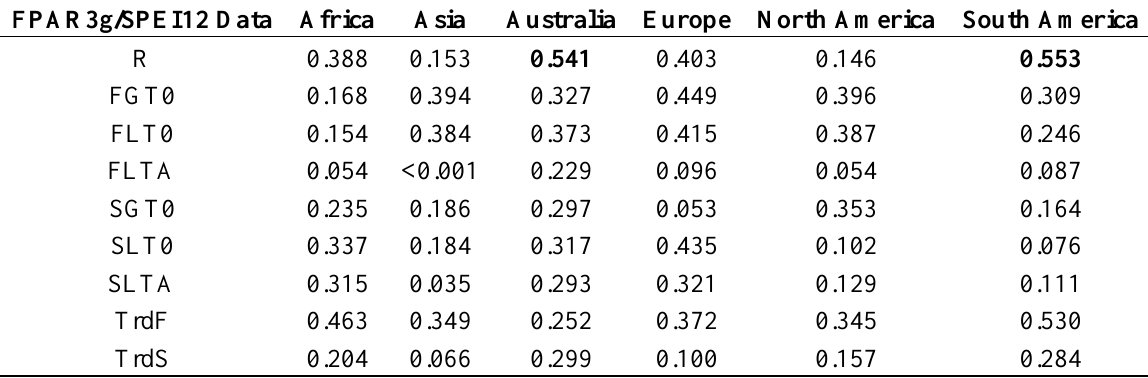
Table 1. Adjusted R 2 values of the univariate one-way Anova models in explaining the variance of the FPAR3g and SPEI12 anomalies and trends (dependent variables) with the ERTs per continents as predictors.